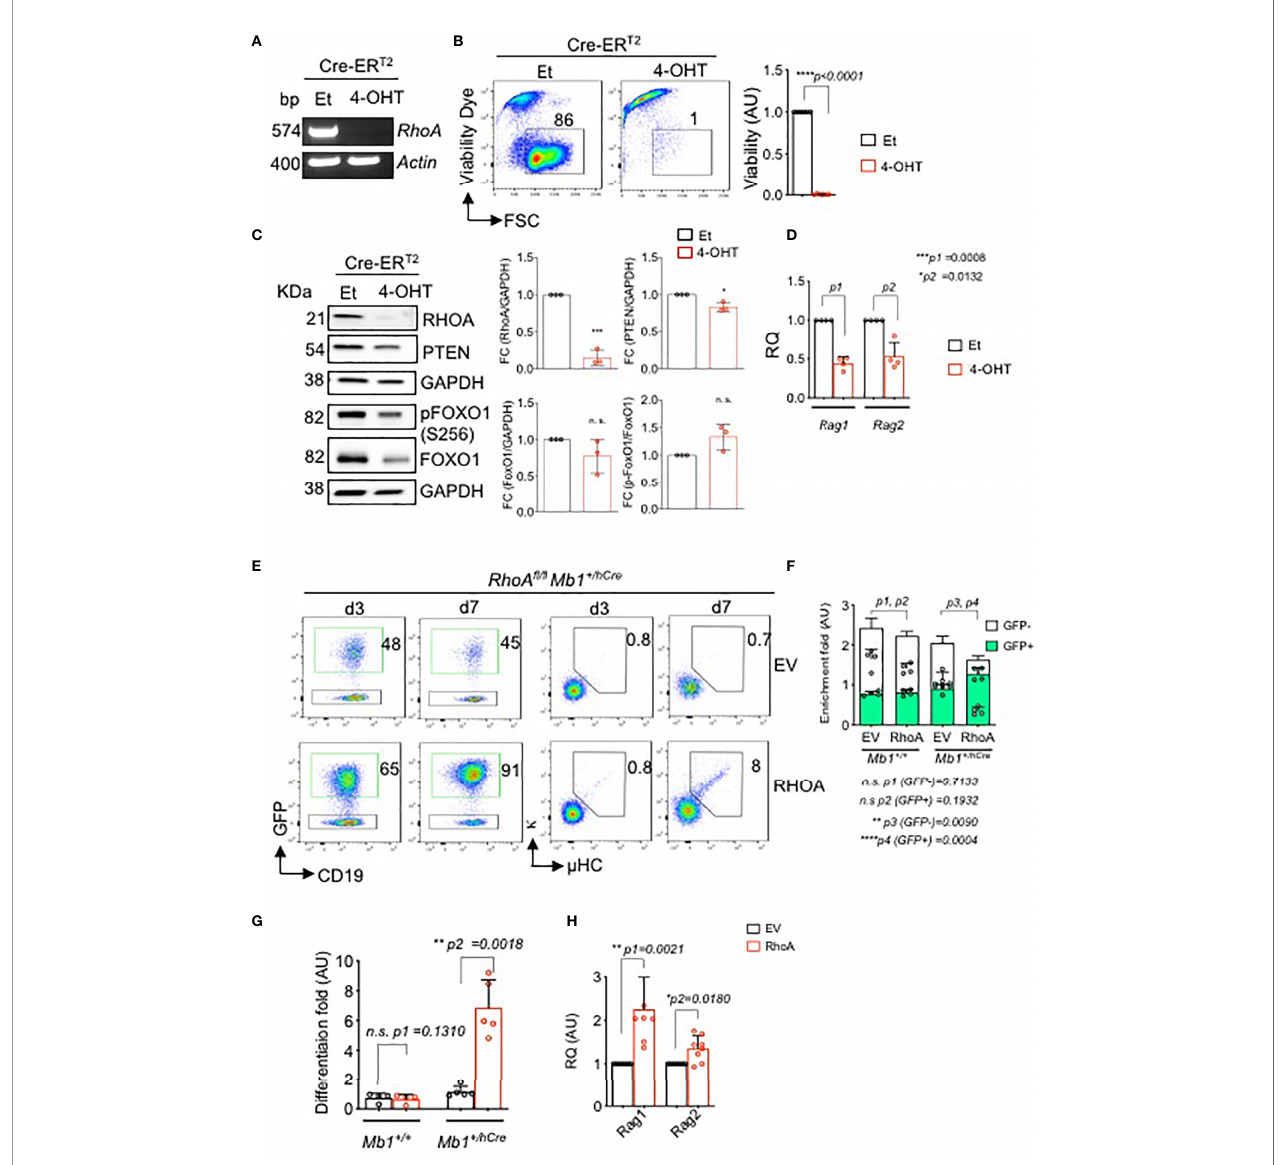
FIGURE 5 | In vitro deletion of RhoA leads to cell death and impaired immunoglobulin gene rearrangement and B cell differentiation. RhoA fl / fl Mb1 +/+ pre-B cells were transduced with Cre-ER T2 . Cells were then treated with either 4-OHT to induce Cre expression, or with Et. (A) RT-PCR analysis for RhoA gene expression after 2 days of tamoxifen induction. Actin was used as a loading control. bp: base pair. (B) Left- fl ow cytometric analysis of viability of RHOA deleted cells using Sytox dye after 4 days of tamoxifen induction. Right- the fold change of living cells after treatment with either Et or 4-OHT at day 4. N=6 independent samples per group, and error bars represent mean ± SD. Paired t-test, two-tailed. (C) Left- western blot analysis showing expression of RHOA, PTEN and phospho FOXO1 after 2 days of tamoxifen induction. Data representative of three independent experiments. Right- quanti fi cation of the western blots. RHOA, PTEN and total FOXO1 blots are normalized with GAPDH while p-FOXO1 is normalized with total FOXO1. Bars represent mean ± SD. Statistical test- unpaired t test. (D) Quantitative RT-PCR showing Rag1 and Rag2 expression after RhoA deletion. N=4 independent samples per group, and error bars represent mean ± SD. Paired t-test, two-tailed. (E) RhoA fl / fl Mb1 +/+ or RhoA fl / fl Mb1 +/hCre pre-B cells were reconstituted with either an empty vector (EV, pMIG) or with RhoA retroviral expression vector (pMIG-RHOA). Left- Flow cytometric analysis showing enrichment of RhoA fl / fl Mb1 +/hCre cells transduced with either an EV or RHOA (GFP + population) after 3 and 7 days of transduction. Right- Flow cytometric analysis showing an increase in the percentage of differentiated cells (µ + kappa + ) in RhoA -de fi cient cells which were reconstituted with RhoA (N=5). (F) Quanti fi cation of enrichment of GFP + pre-B cells from RhoA fl / fl Mb1 +/+ or RhoA fl / fl Mb1 +/hCre mice reconstituted with either EV or RhoA . Enrichment fold represents the ratio of CD19 + GFP + or CD19 + GFP - at day 7 relative to day 3. N=4 independent samples per group, and error bars represent mean ± SD. Paired t-test, two-tailed. (G) Quanti fi cation of enrichment of differentiated cells (µ + kappa + ) as calculated by the ratio of µ + kappa + at day 7 relative to day 3. N=4 independent samples per group, and error bars represent mean ± SD. Paired t-test, two-tailed. (H) Quantitative RT-PCR showing up-regulation of Rag1 and Rag2 gene after RHOA reconstitution in RhoA fl / fl Mb1 +/hCre . N=4 independent samples per group, and error bars represent mean ± SD. Paired t-test, two-tailed. *p<0.05, **p<0.01, ***p< 0,001, ****p<0.0001, ns, not signi fi